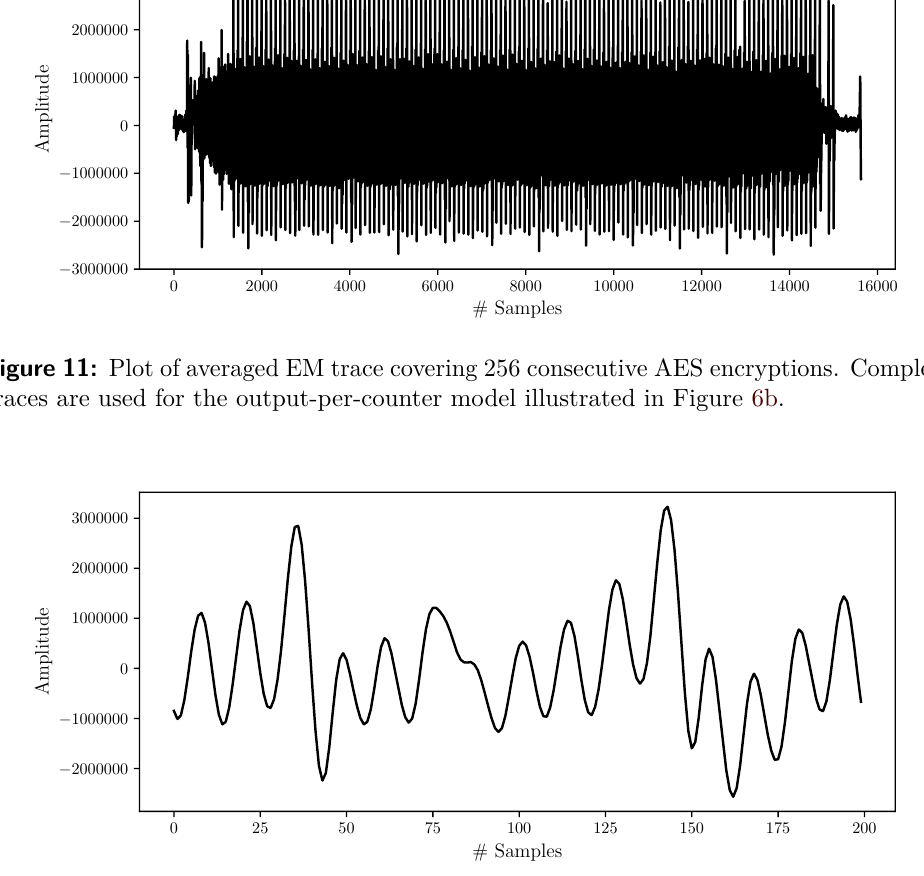
Figure 12: Segment of EM trace as used for the model-per-ctr approach described in Figure